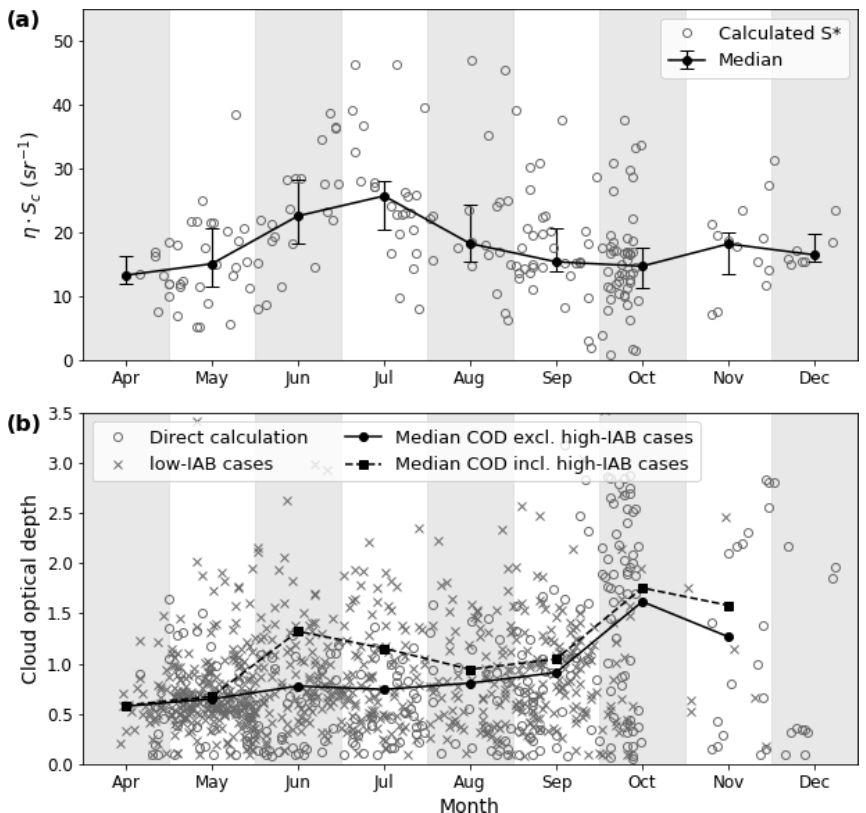
Figure 4. (a) Monthly variations of lidar ratio values over the IAOOS campaigns. The open circles represent the measurements. The filled markers represent the monthly medians, with the whiskers indicating the 25th and 75th percentiles. (b) Monthly evolution of single-layer COD for five IAOOS buoys. Open circles represent the Rayleigh-derived cloud optical depths. Crosses correspond to the low-IAB COD values (Sect. 3.2.4). Filled markers represent the monthly medians, when high-IAB cases are excluded (circles) or included (squares). These medians are calculated when more than 15 data points are